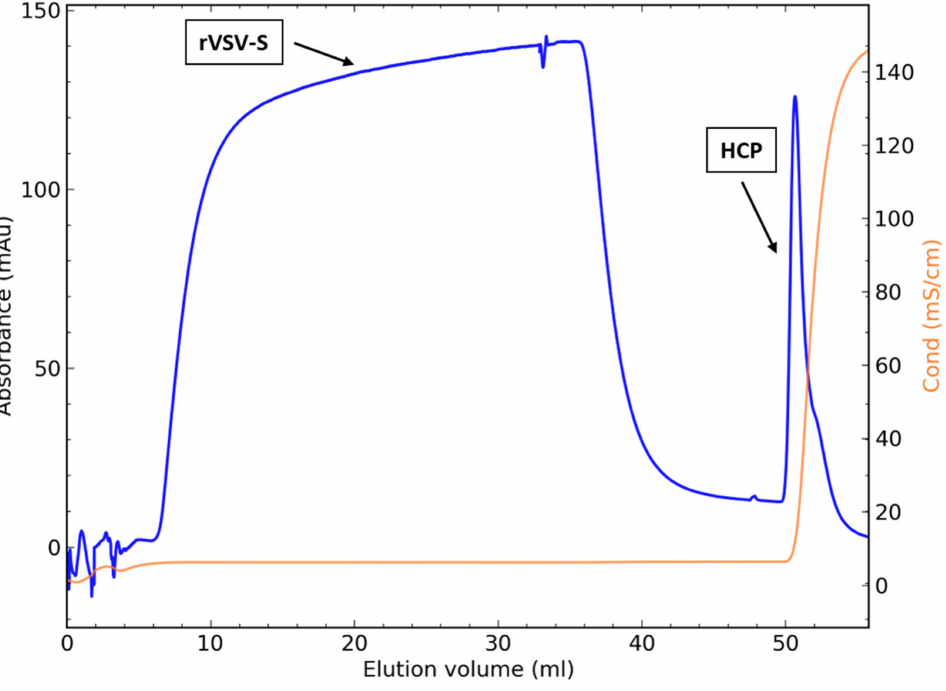
Figure 2. Chromatogram of a CC700 packed-bed 1 mL column. The flow-through was collected and analyzed for virus infectivity and HCP